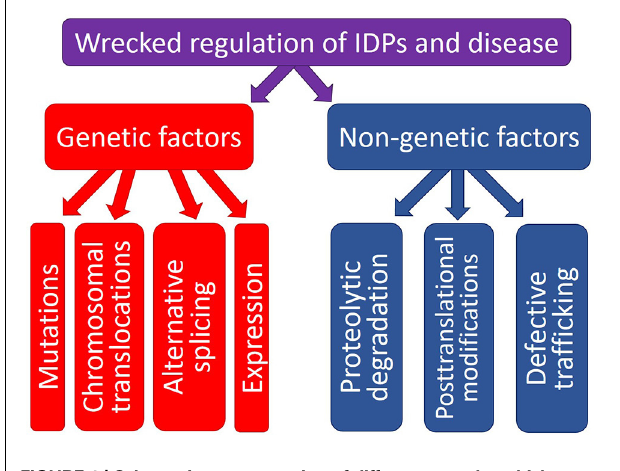
FIGURE 2 | Schematic representation of the genetic translocation mechanism, where instead of two normal functional proteins a hybrid protein is produced with aberrant biological